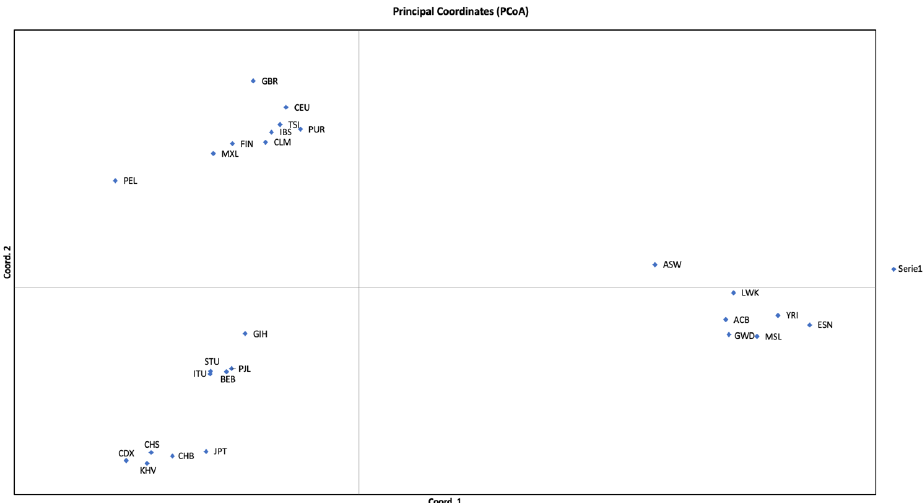
Figure 1. Principal Coordinates Analysis (PCoA) based on autosomal STR data regarding the 26 populations analyzed in the 1000 Genomes Project. Each point represents a population sample. More details on these populations are available in Supplementary Table S2. Coordinates 1 and 2 account for 39.15% and 19.25% of the variance, respectively.